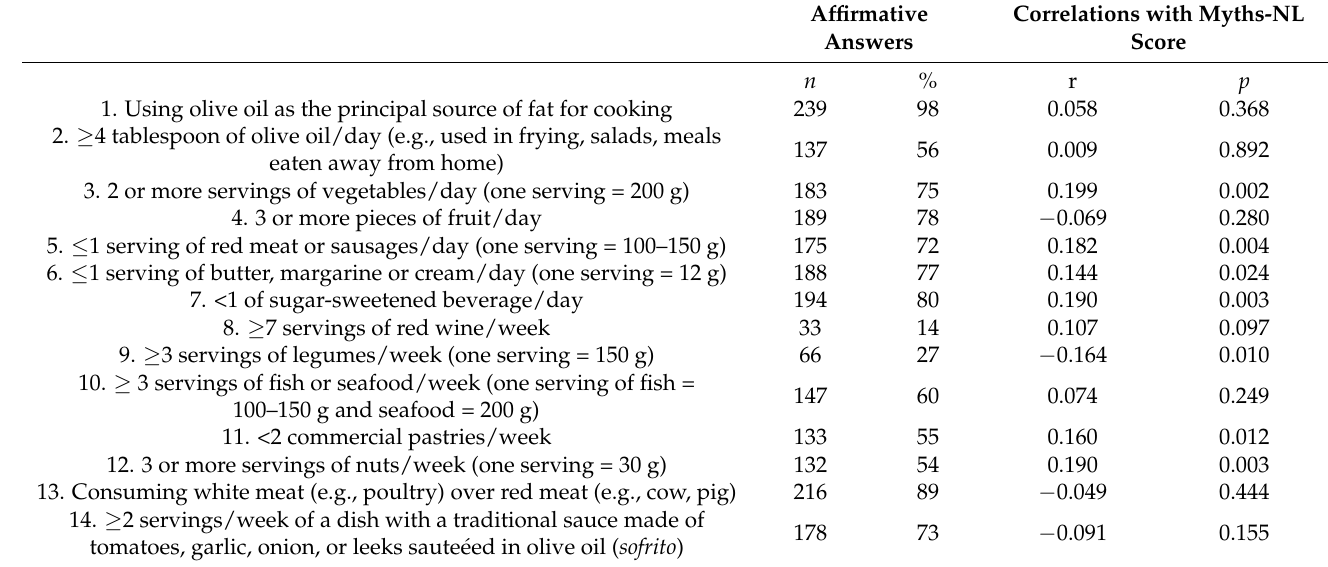
Table 4. Affirmative answers to each of the MEDAS questions and correlations with the Myths-NL score ( n =